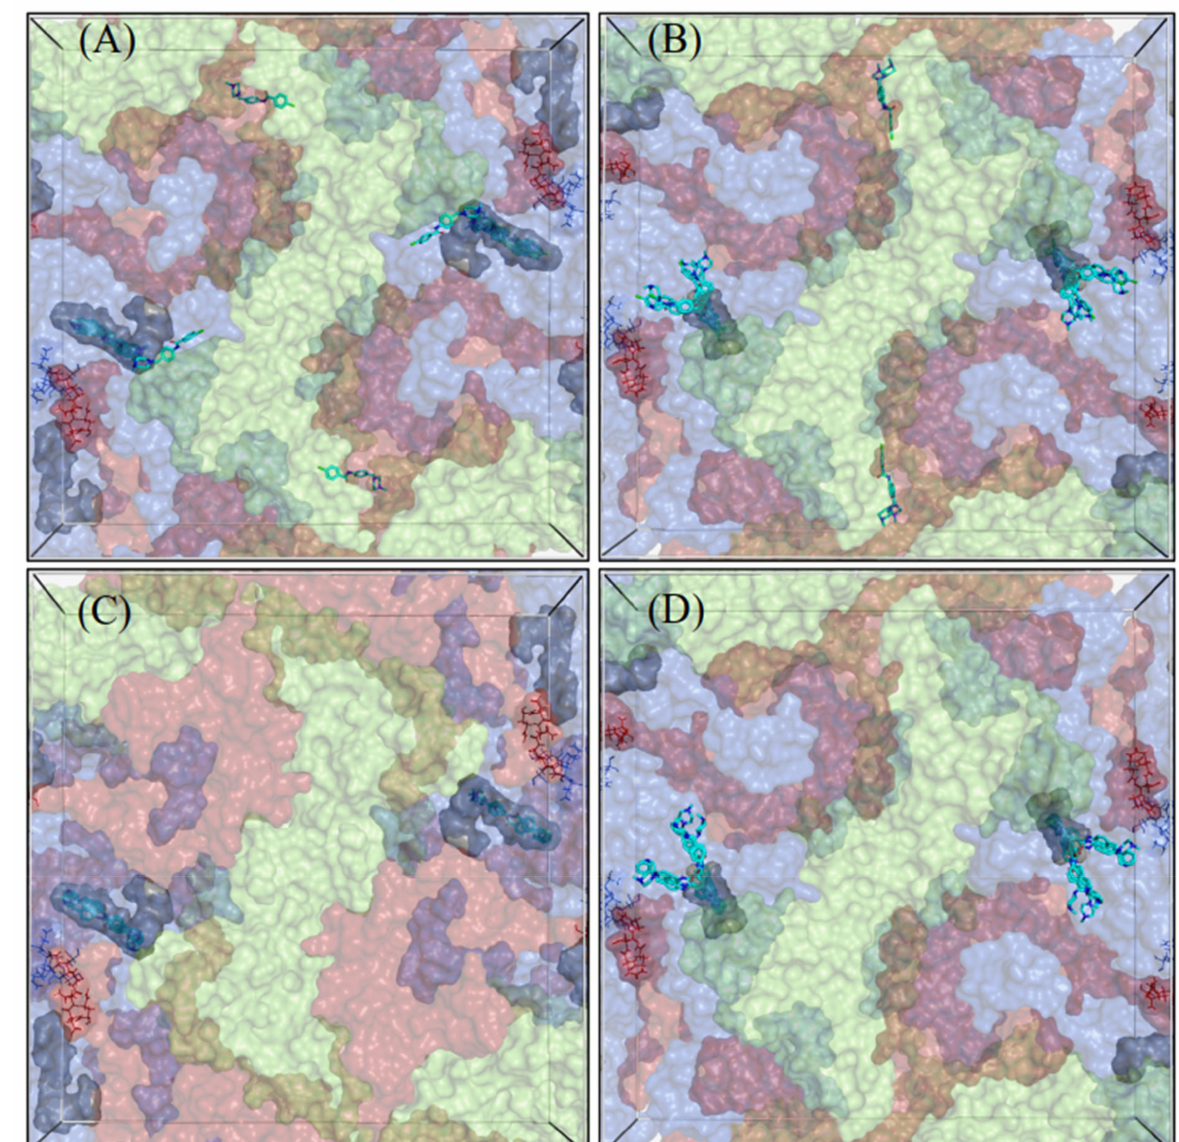
Figure 8. Docking grid boxes centered at the 2-fold axis of the virus capsid. ( A , C ) for CVA9 and ( B , D ) for CVB3. The docking poses of CL212 (upper panel) and CL213 (lower panel) are represented as cyan sticks. The hydrophobic pocket is represented as a grey surface and the Butcher-Neyts pocket as lines. The capsid proteins VP1–VP3 are colored blue, light green, and red, respectively. VP4 is not